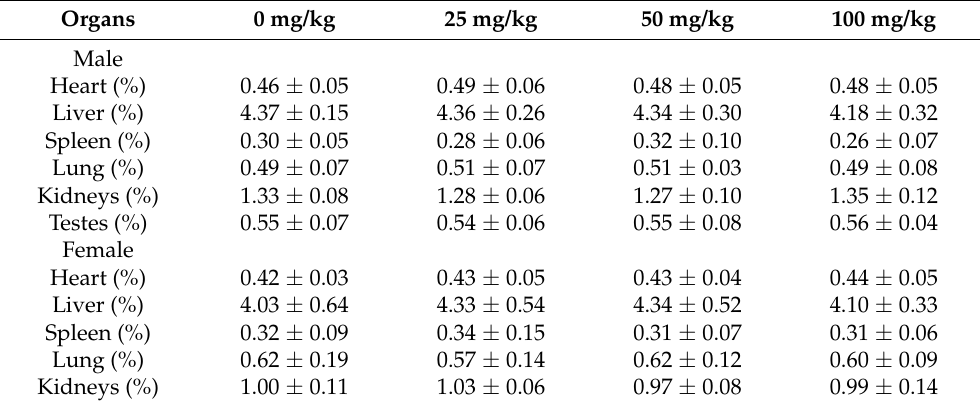
Table 6. Organ weights relative to body weight in the repeated-dose 30-day oral toxicity study. Organs